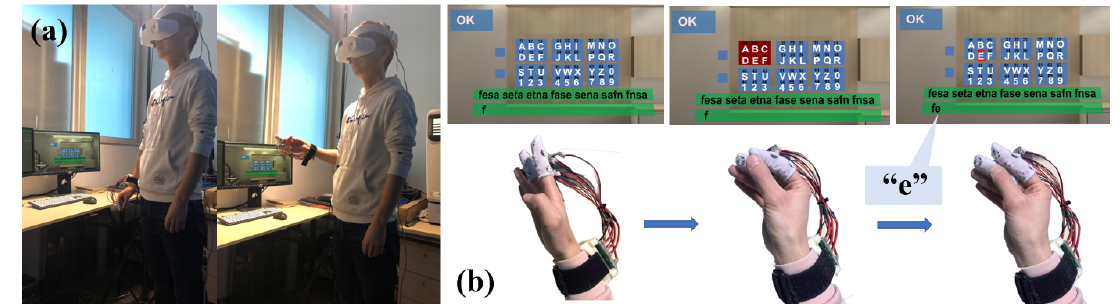
Figure 2. Text entry system based on the HiFinger technique. ( a ) A standing user is inputting with HiFinger in head-mounted display (HMD)-based virtual environments (VEs); ( b ) the process of entering “e” with HiFinger. Step one: a user touches the “Number 1” pressure sensor to specify the “Number 1” character set whose color turns red; step two: a user touches the “Number 5” pressure sensor to specify the character